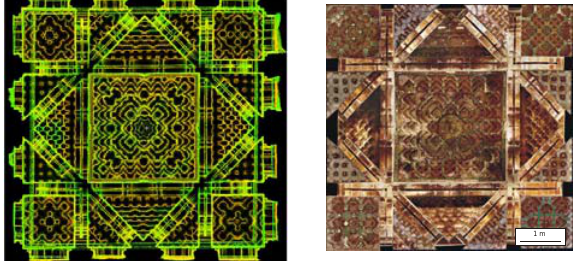
Figure 12. Left: Vault point cloud as seen from the floor. Right: orthoimage at 1 mm of resolution.